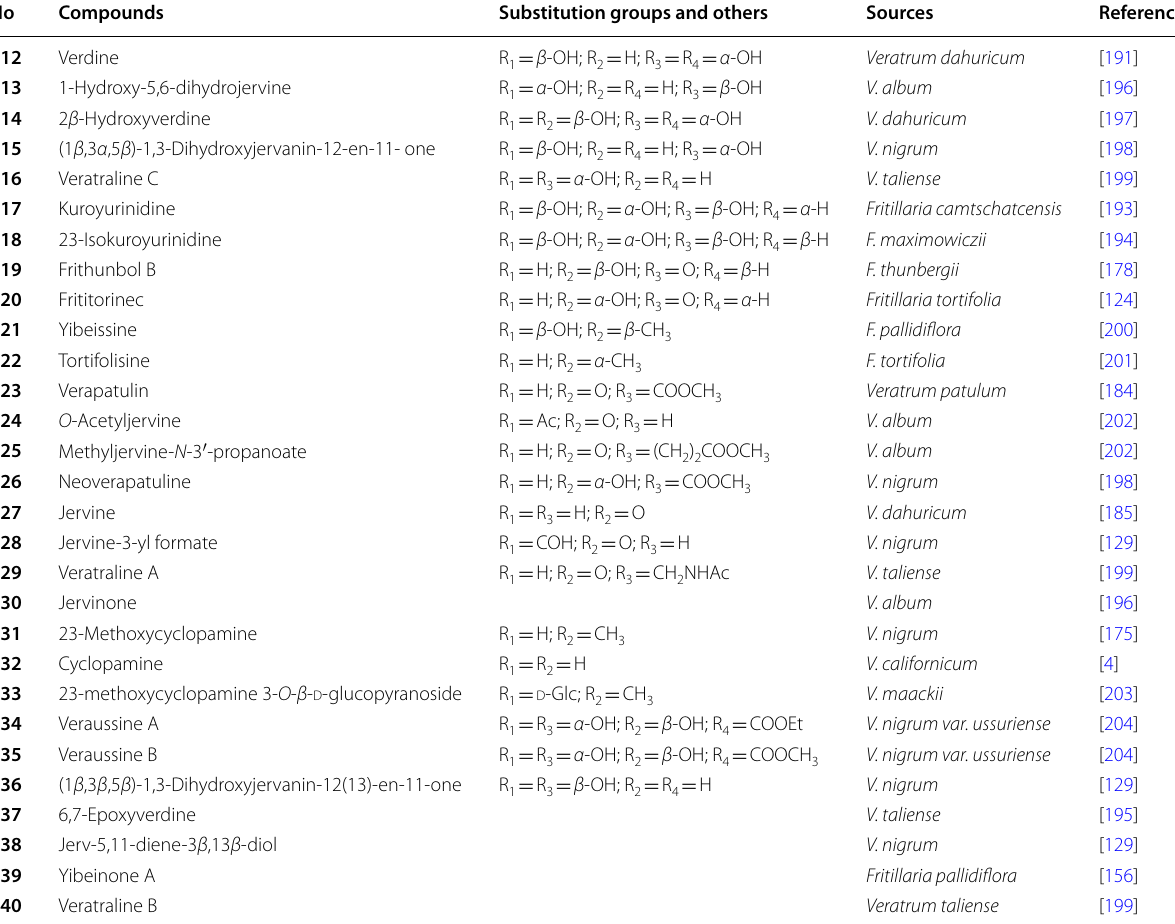
Table 8 Structures and sources of jervine type steroidal alkaloids